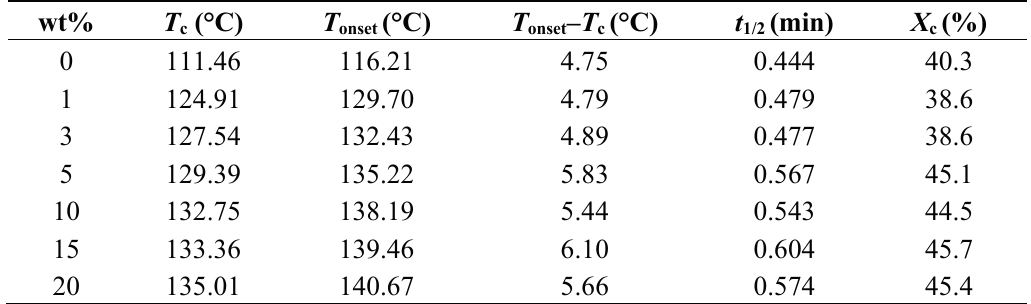
Table 1. Crystallization properties of PP/GNs composites.